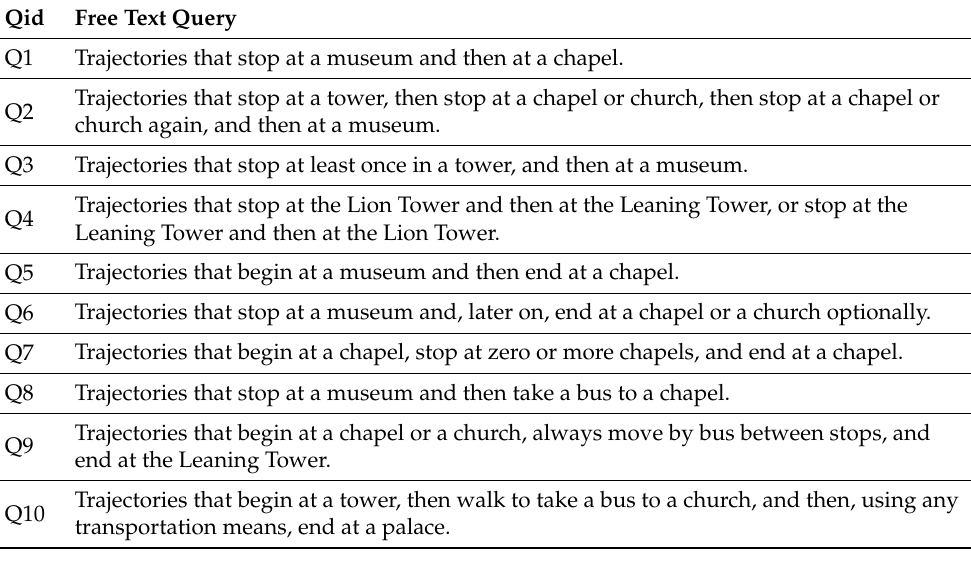
Table 16. Semantic trajectories queries for the city of Pisa.